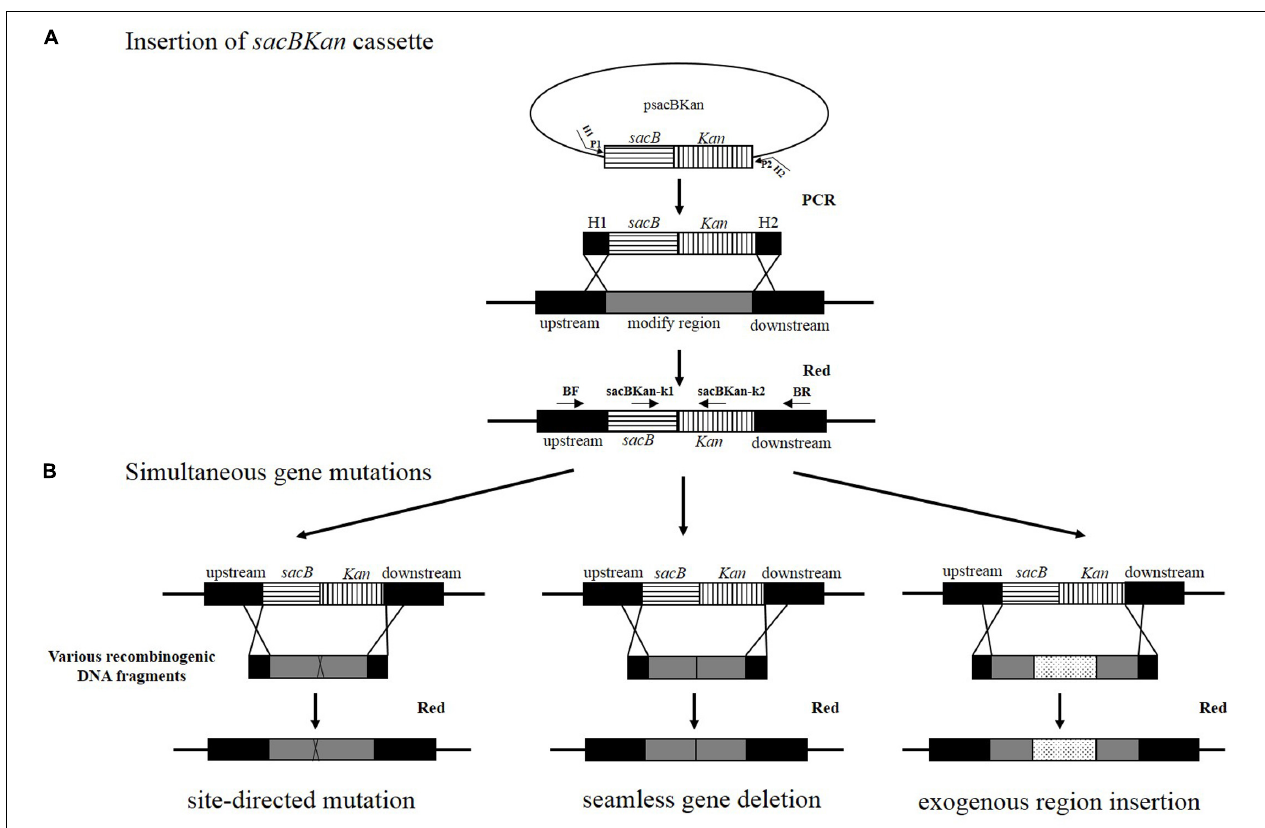
FIGURE 1 | Rationale of the simultaneous gene multiple modifications approach. (A) In the first step, the sacBKan cassette obtained by using primers H1P1/H2P2 is inserted into the target locus using the red homologous recombination system, and Kan-resistant strains are selected. H1P1/H2P2 included 40- to 50 nt extensions (H1/H2) homologous to regions adjacent to the target-specific locus and 20 bp sequences corresponding to the P1/P2 sequences from psacBKan. Proper sacBKan cassette insertion mutant is confirmed by using locus-specific primers (BF and BR) with the corresponding common test primer (psacBKan-k1 or k2) dependent on four reactions by using primer pairs BF/BR, BF/psacBKan-k2, psacBKan-k1/BR, and psacBKan-k1 or k2. (B) In the second step, different types of DNA recombinogenic DNA fragments with short homologous arms obtained by using seamless assembly technology are introduced by electroporation to construct site-directed mutation, seamless gene deletion, and exogenous region insertion. Finally, the sucrose-resistant clones are selected on LB plates with 8% sucrose. Positive clones are confirmed by using primer locus-specific primer BF/BR and